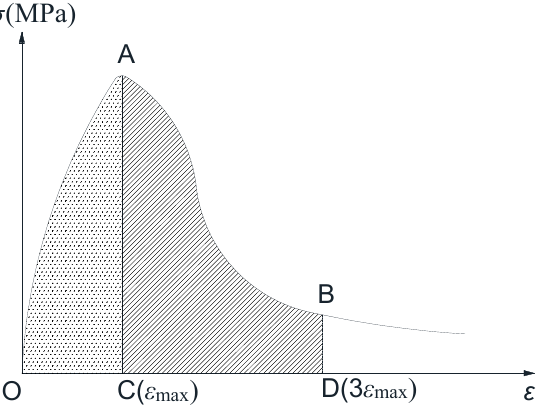
Figure 13. ECC typical full curve of compressive stress and strain.